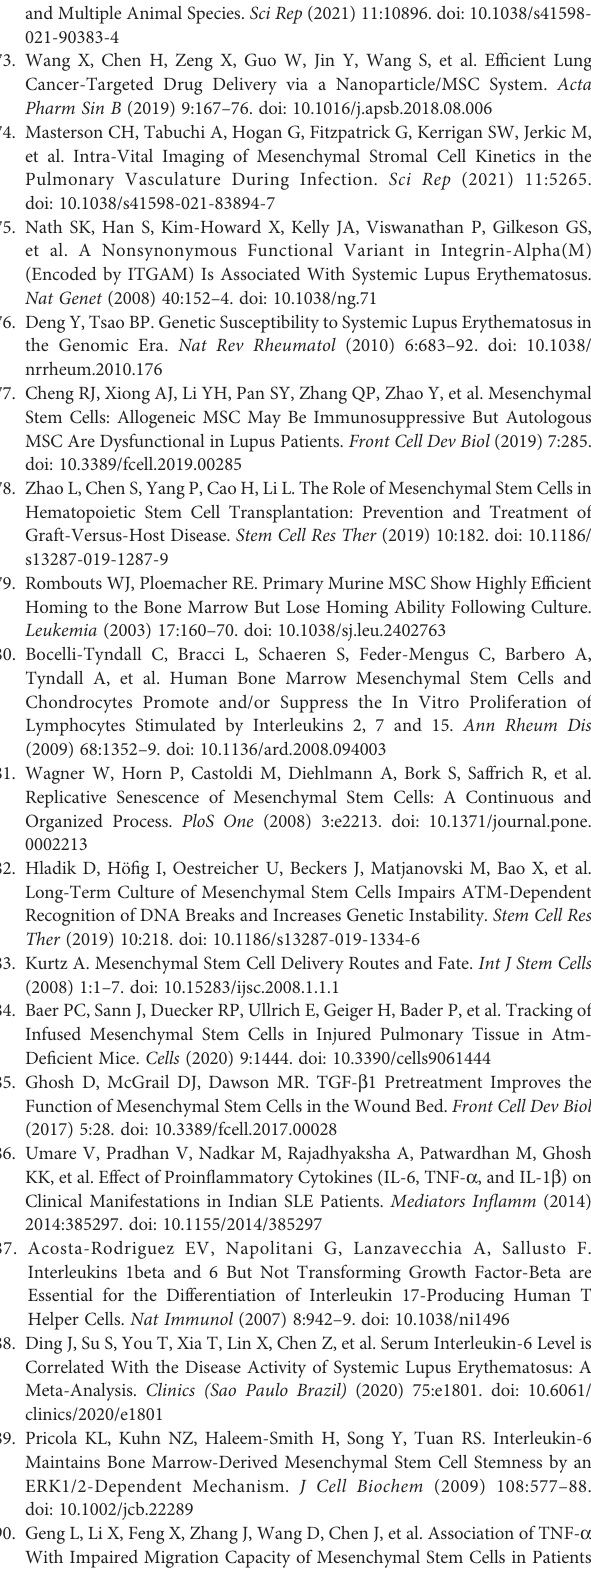
Figenschau SL, et al. Mesenchymal Stem Cells and T Cells in the Formation of Tertiary Lymphoid Structures in Lupus Nephritis. Sci